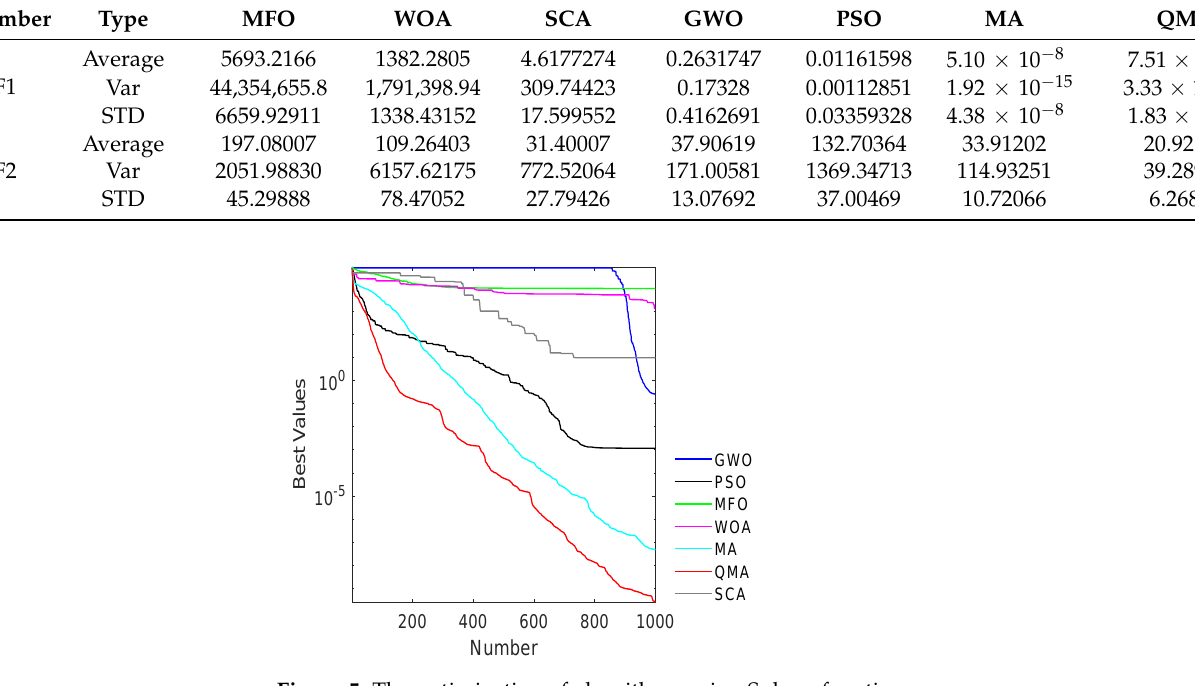
Figure 5. The optimization of algorithms using Sphere function.